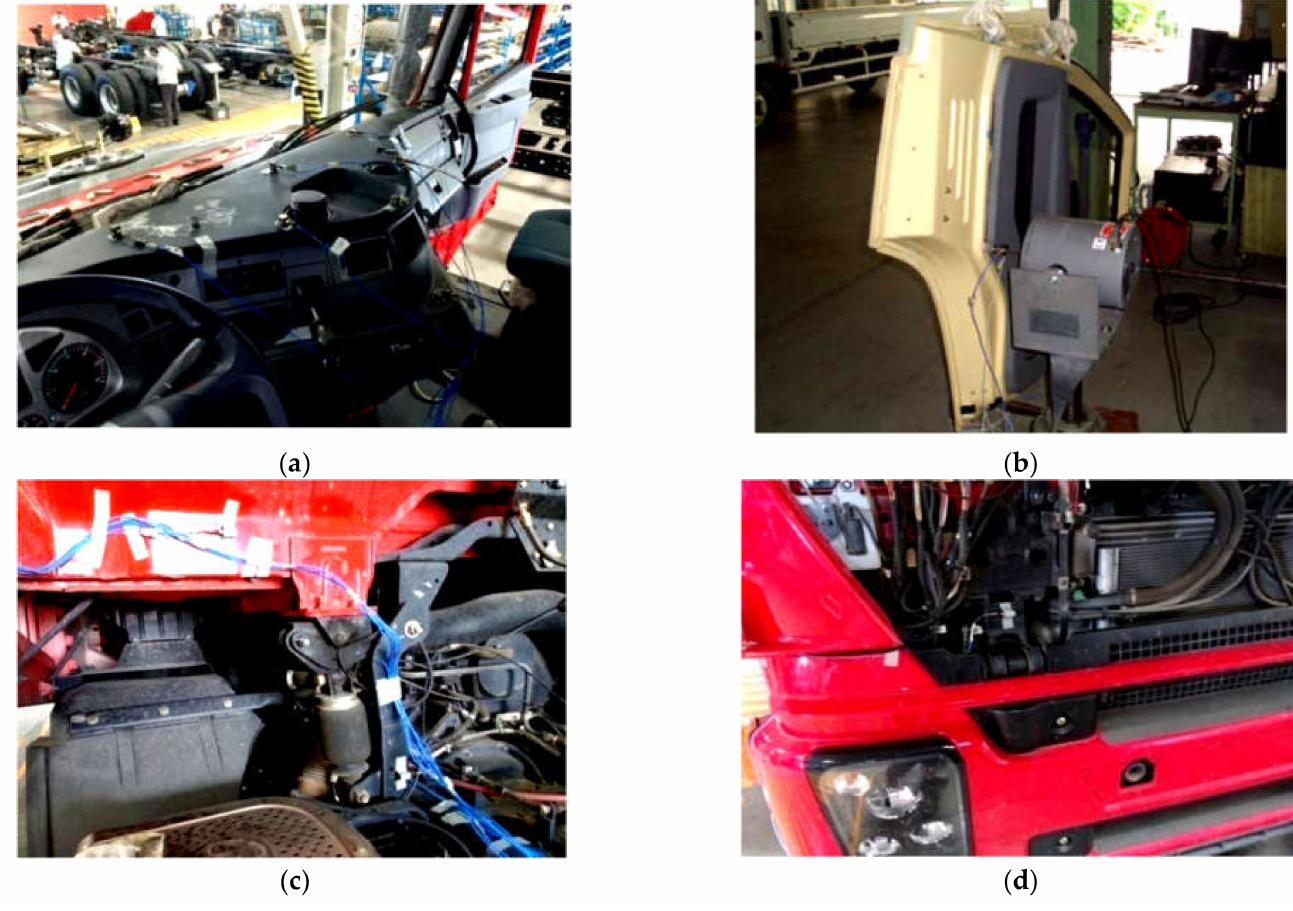
Figure 7. Internal loss factor test. ( a ) The dashboard loss factor testing; ( b ) The door inside loss factor testing; ( c ) Loss factor testing within coaming after; ( d ) Loss factor testing in the bottom of the front